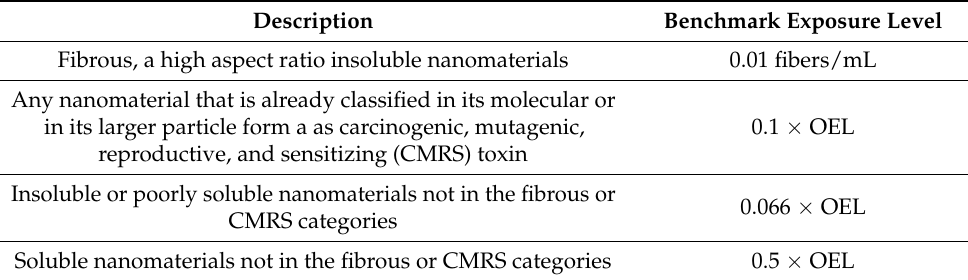
Table 10. Occupational exposure limit values (OELs) for nanomaterial